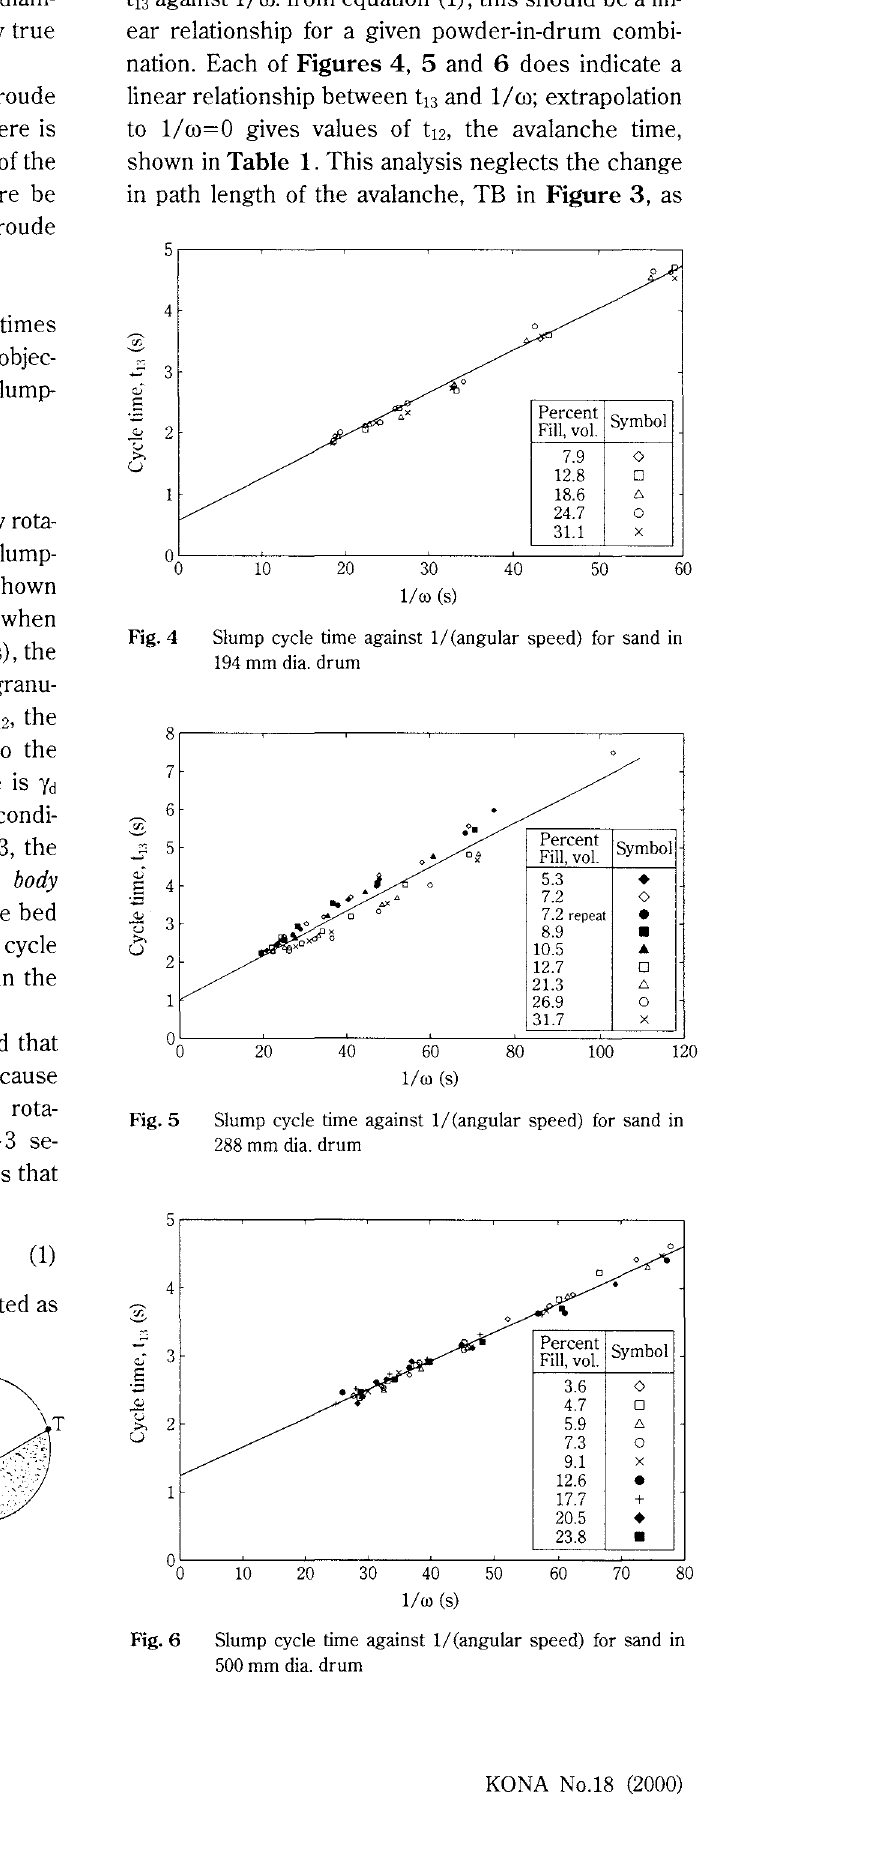
Fig.6 Slump cycle time against 11 (angular speed) for sand in 500 mm dia.